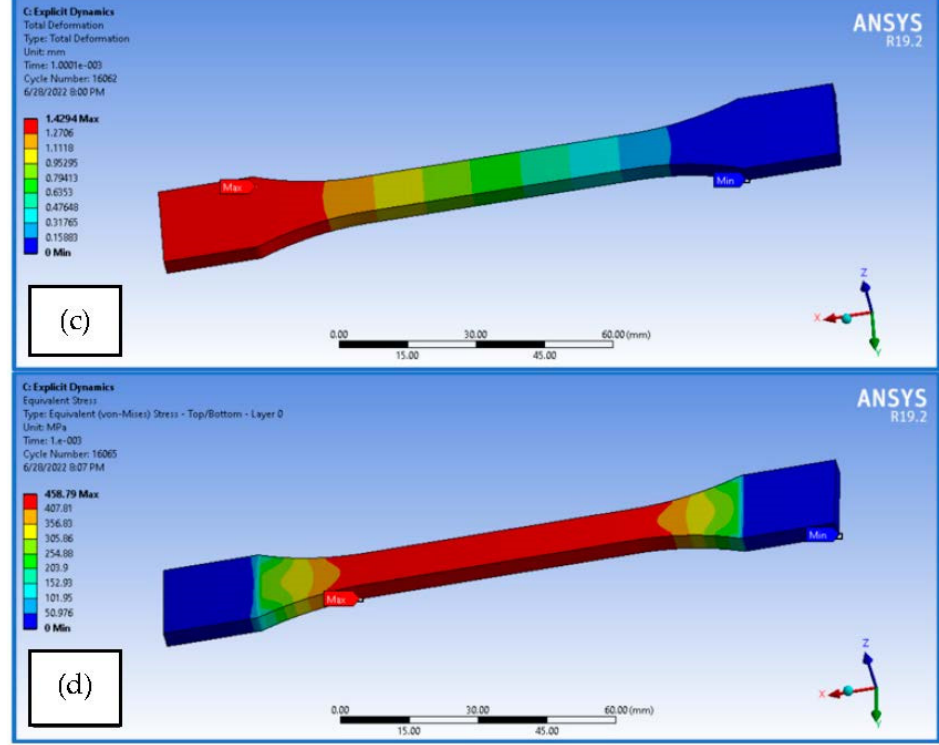
Figure 17. FEA results obtained for the tensile and flexural tests—( a ) flexural test vertical displacement, ( b ) normal stress on specimen during flexural test ( c ) tensile test total deformation and ( d ) tensile test equivalent (von-Mises) stress.